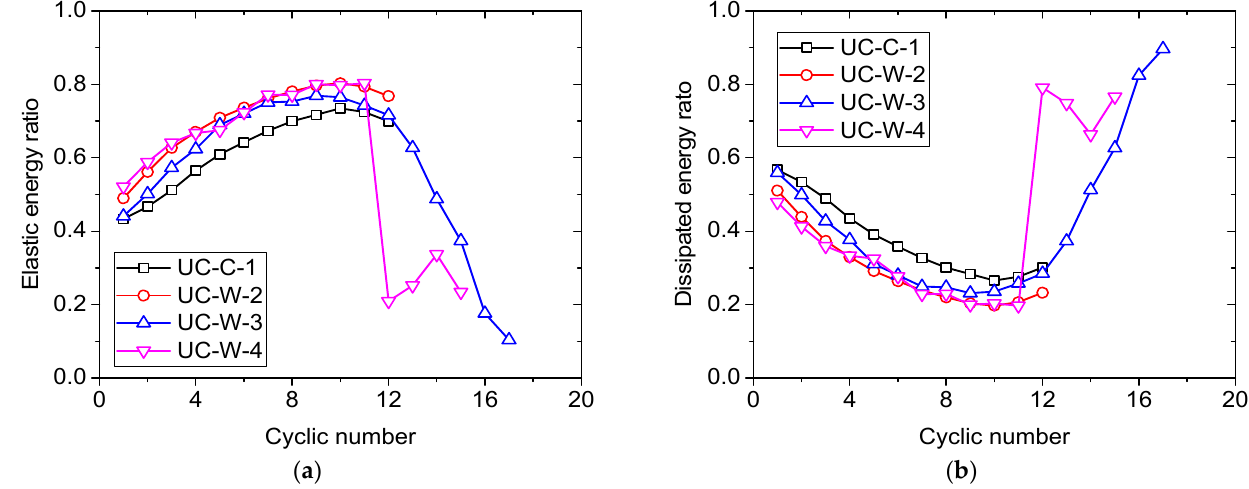
Figure 15. ( a ) Variation of elastic energy ratio with number of cycles, and ( b ) variation of dissipated energy ratio with number of cycles.